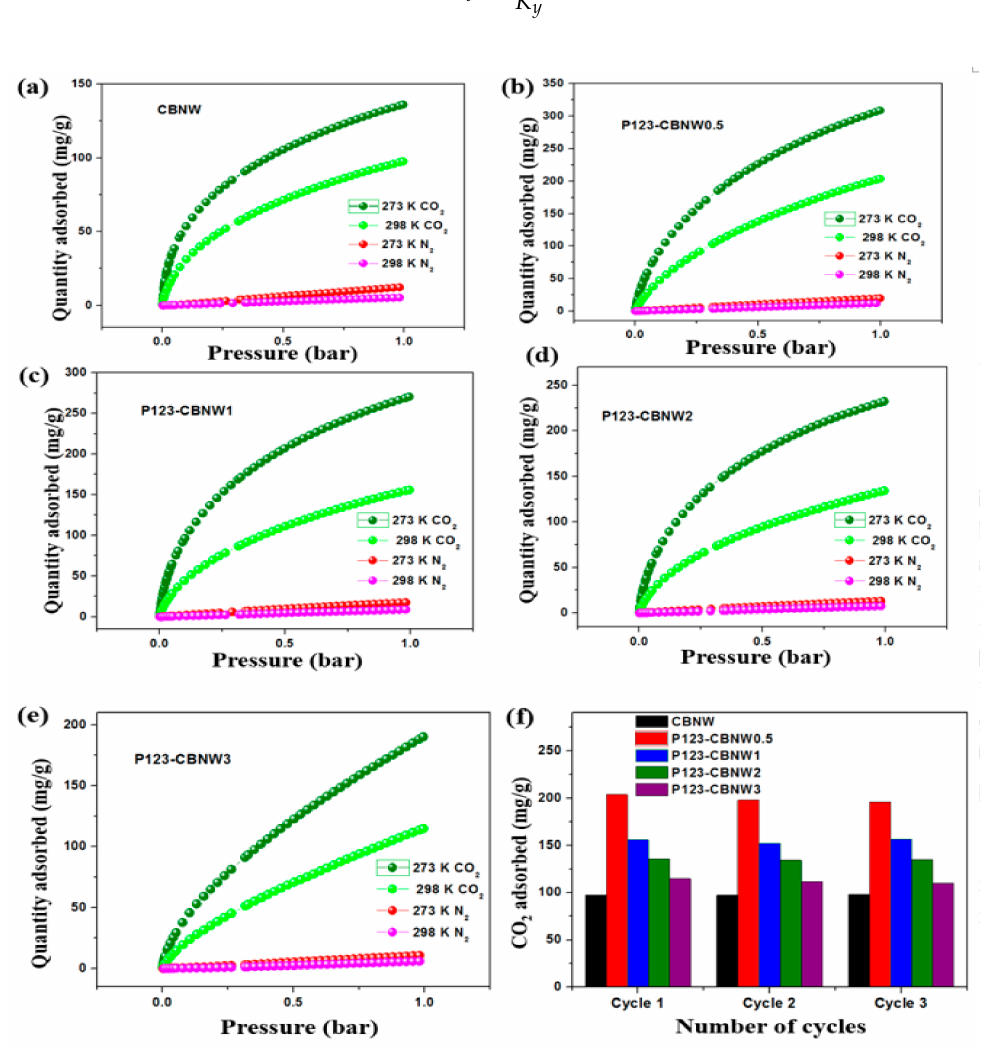
Figure 8. CO 2 and N 2 adsorption isotherm plots of CBNW ( a ), P123-CBNW0.5 ( b ), P123-CBNW1 ( c ), P123-CBNW2 ( d ), P123-CBNW3 ( e ), at 273 and 298 K for selective adsorption analysis, and ( f ) adsorption–desorption cycles for adsorbents at 298